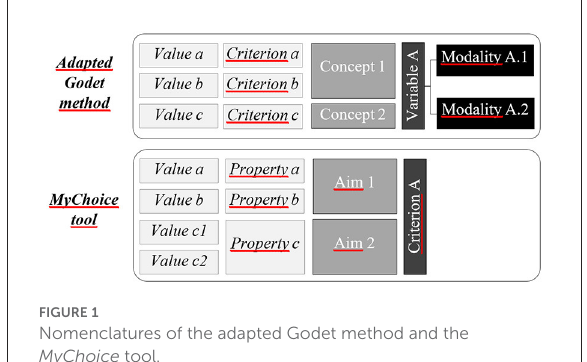
FIGURE1 Nomenclatures of the adapted Godet method and the MyChoice